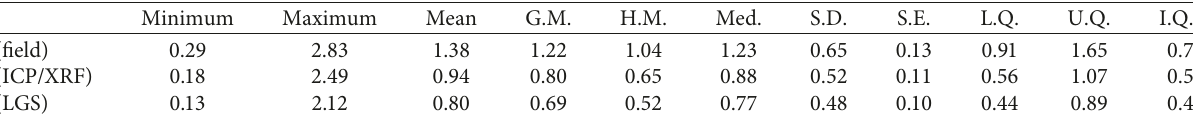
Table 2: Statistic measures of the activity concentration index ( I ) sets from different procedures for estimation of isotopes specific activity and related p values.